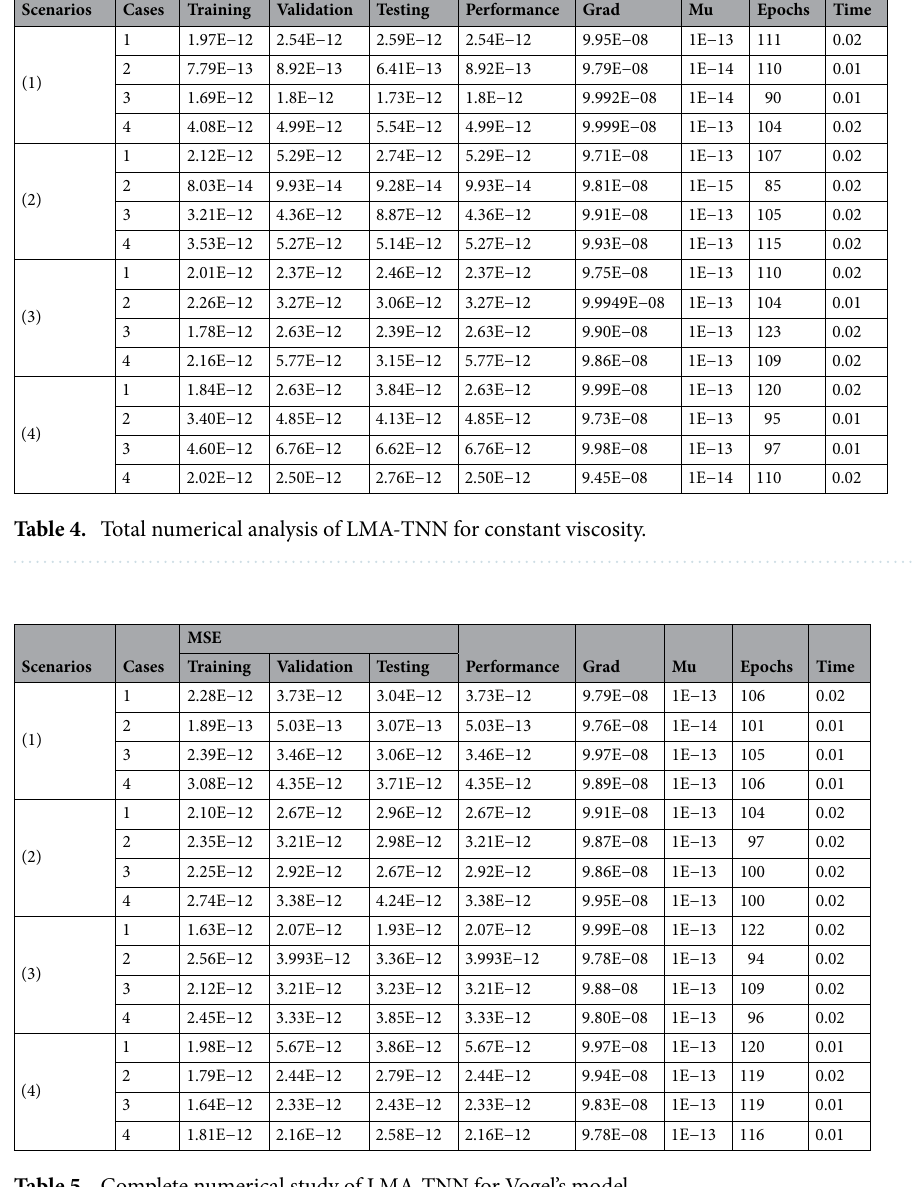
Table 5. Complete numerical study of LMA-TNN for Vogel’s